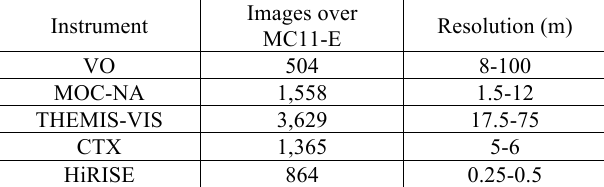
Table 1. High-resolution orbital images of MC11-E.